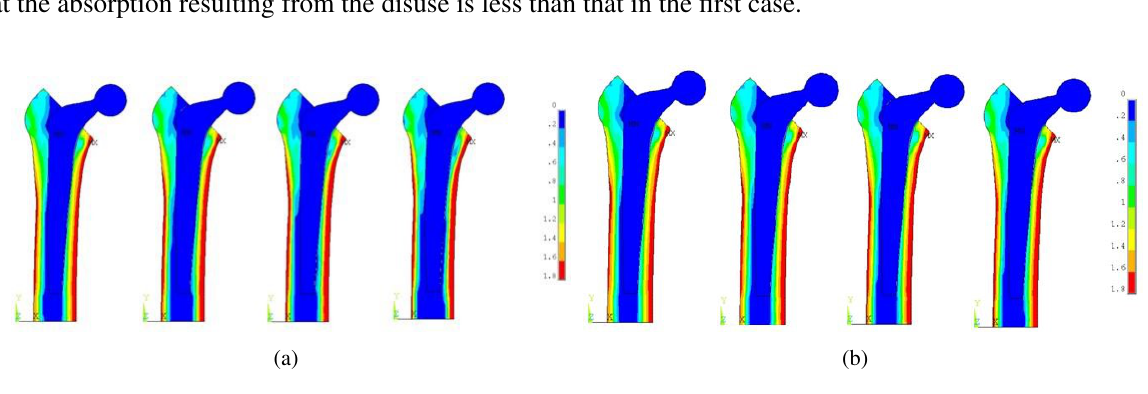
Fig. 7 Bone density change with a pin. (a) The first loading case; (b) The second loading